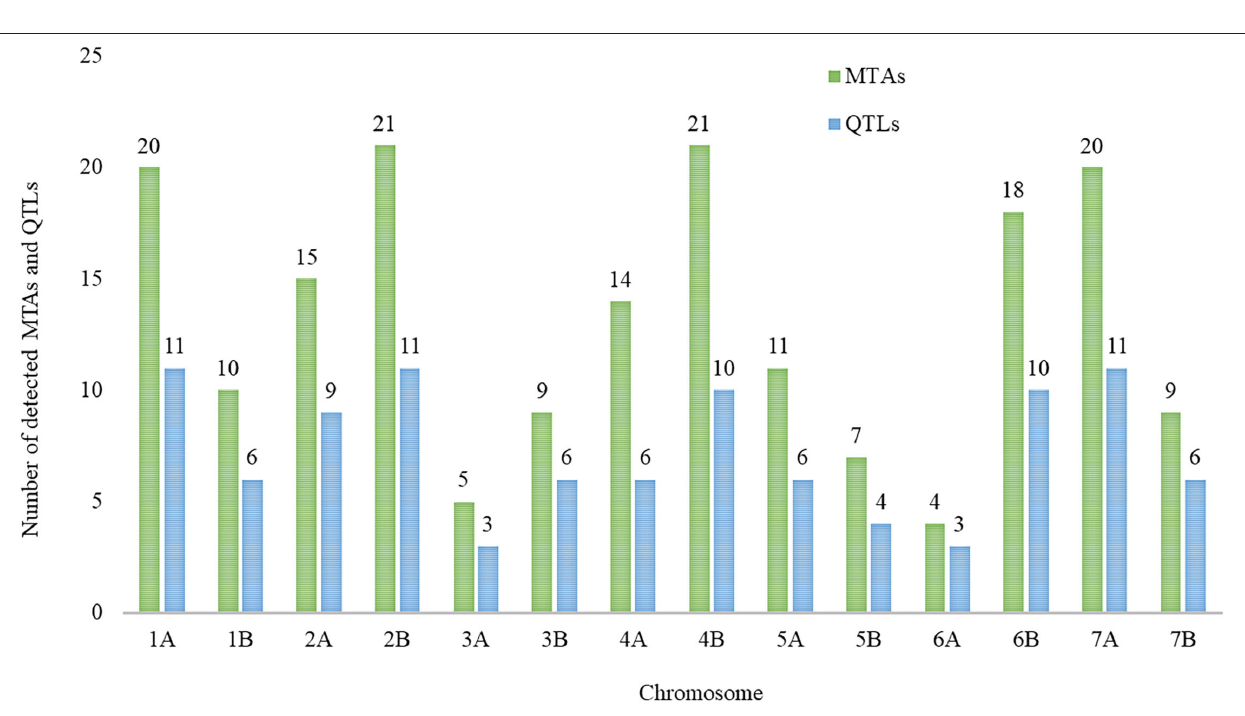
located on chromosomes 4B and 6B between 649,804,818– 659,833,072 and 563,024,848–573,053,102 bp,